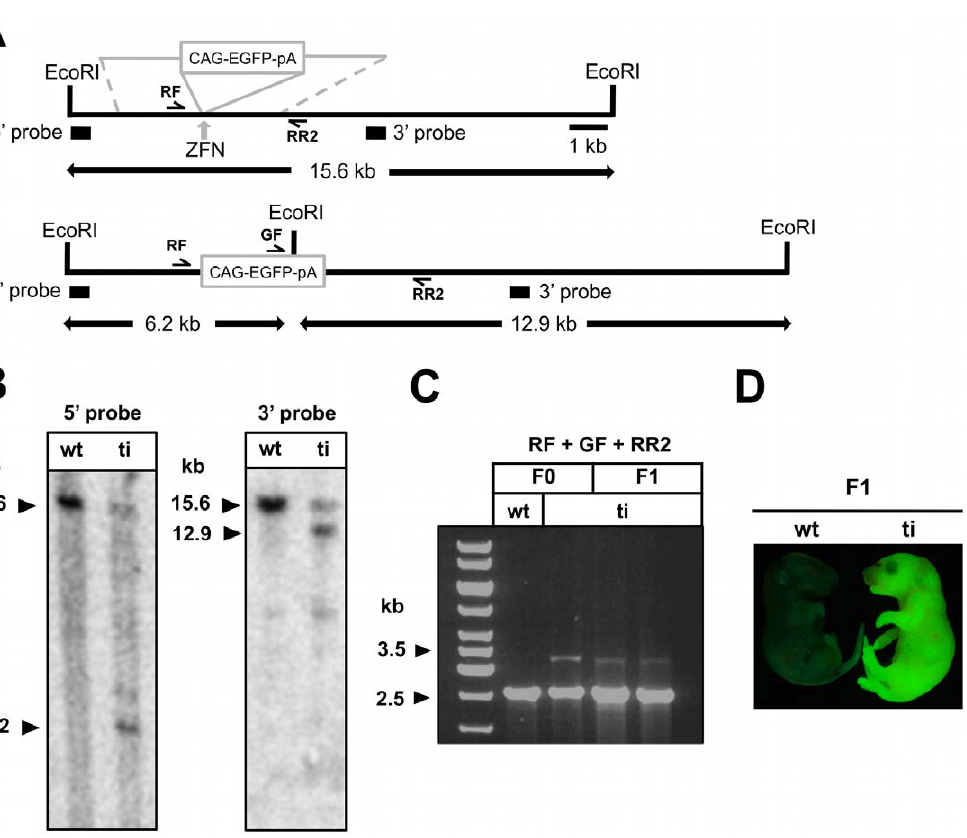
Figure 2. ZFN 204/205 promote ROSA26 targeting by homologous recombination in mouse zygotes. (A) HR targeting strategy for the insertion of the targeting vector gtR26_EGFP carrying EGFP driven by a CAG promoter into the ROSA26 locus. (B) Southern blot analyses of Eco RI digested genomic DNA from a GFP-fluorescent animal showing site-specific integration into the ROSA26 locus. Both 5 9 and 3 9 probes detect only one expected fragment in the DNA of wild-type (wt) animal. Additional fragments detected in the DNA of targeted animal (ti) are consistent with the integration of the CAG-EGFP cassette into one of the ROSA26 alleles. (C) Germline transmission of the ROSA26-CAG-EGFP allele was confirmed by junction PCR in two F1 mice, one of which is depicted in (D). Primers RF, GF, and RR2 generate a 2.5 kb fragment from ROSA26 wt alleles, while an additional 3.2 kb fragment is amplified from a gtR26_EGFP targeted allele.